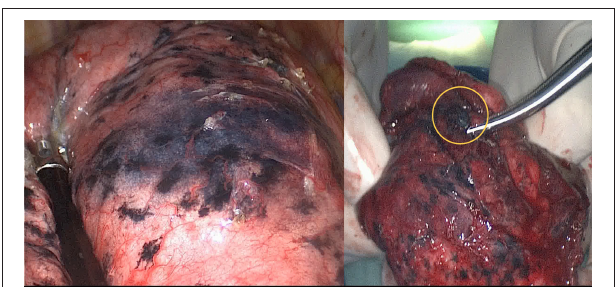
FIGURE 1 | Electromagnetic navigation bronchoscopy-guided methylene blue plus fibrin sealant created a gelatinous appearance with visible stain (left side); the stain kept limited in the resected specimen after 2h of operation (highlighted in a circle, right